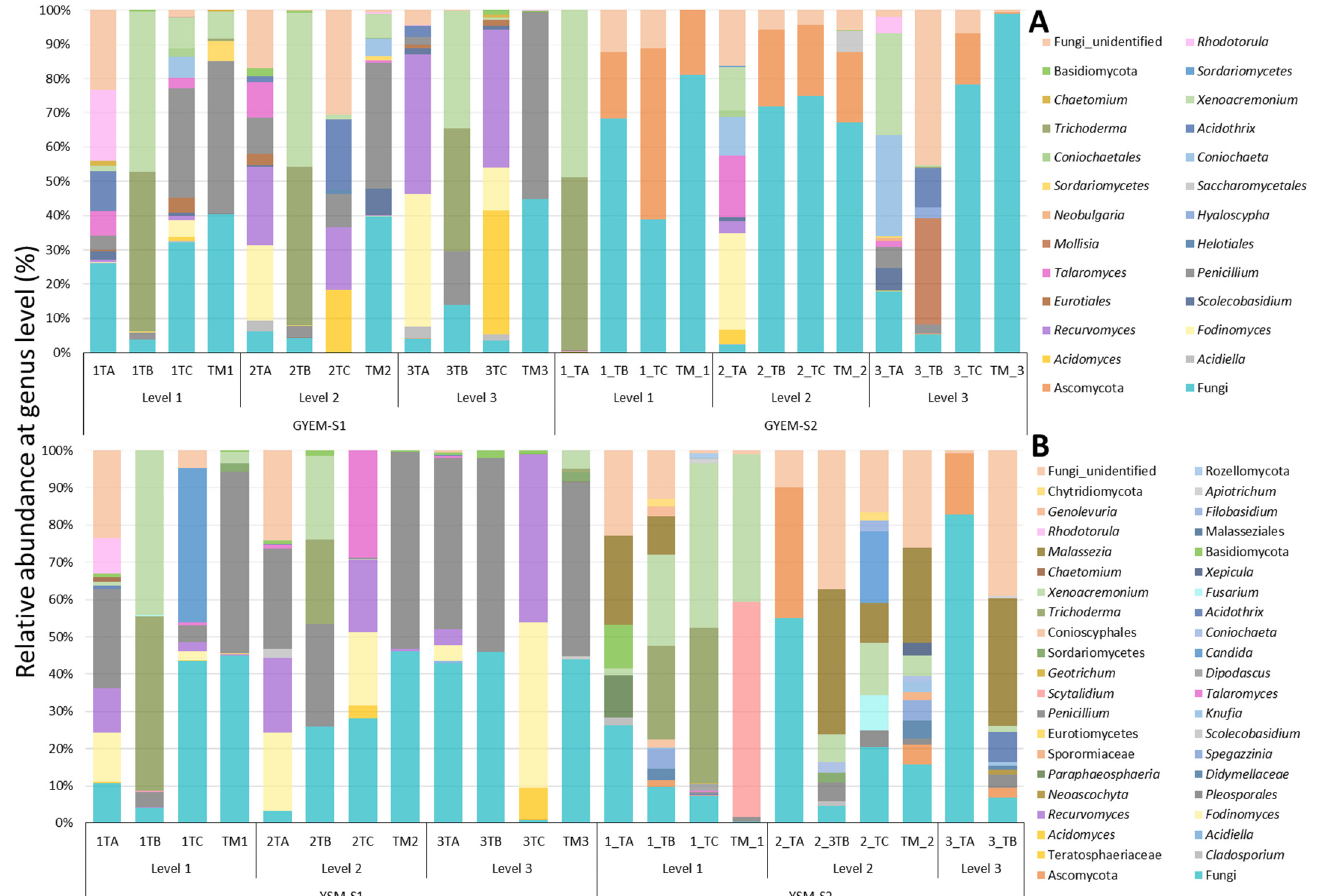
Figure 5. Relative abundance of fungi at genus depth: ( A )—glucose yeast extract media and ( B )— yeast sucrose media .